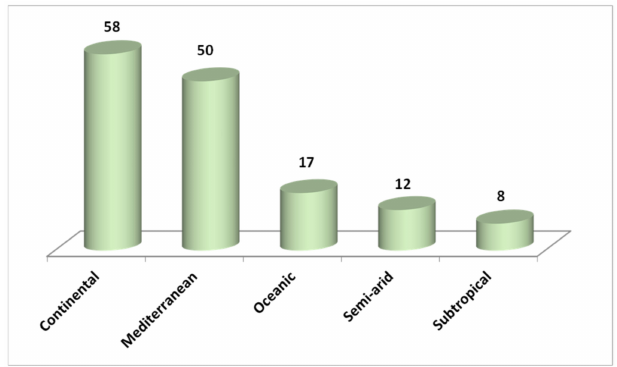
Figure 2. Number of cities by type of climate of Spain.